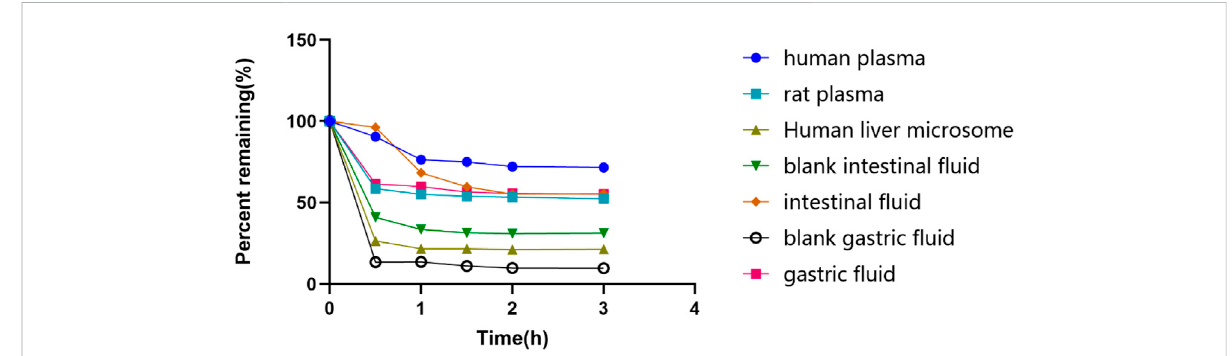
FIGURE 3 The remaining glytrexate percentages over time. Stability of glytrexate following incubation in human liver microsomes, rat plasma, human plasma, blank intestinal fl uid, intestinal fl uid, blank gastric fl uid, and gastric fl uid at 37 ° C for 0, 0.5, 1, 1.5, 2, and 3 h. The glytrexate changes after incubation with different fl uids. The percentage of glytrexate was calculated based on the amount remaining. All glytrexate values are listed as the mean values.